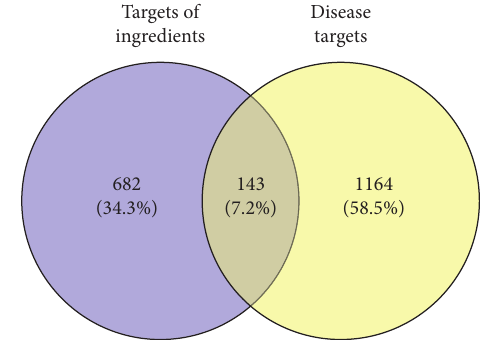
Figure 9: Intersection target between main component targets of LJZD and CIA.